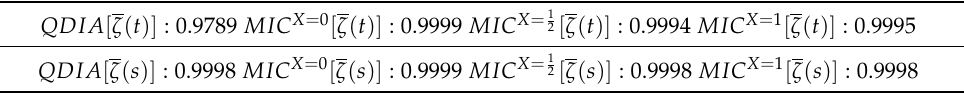
Table 2. Correlations of day 10 non-zonal streamfunction for closures with